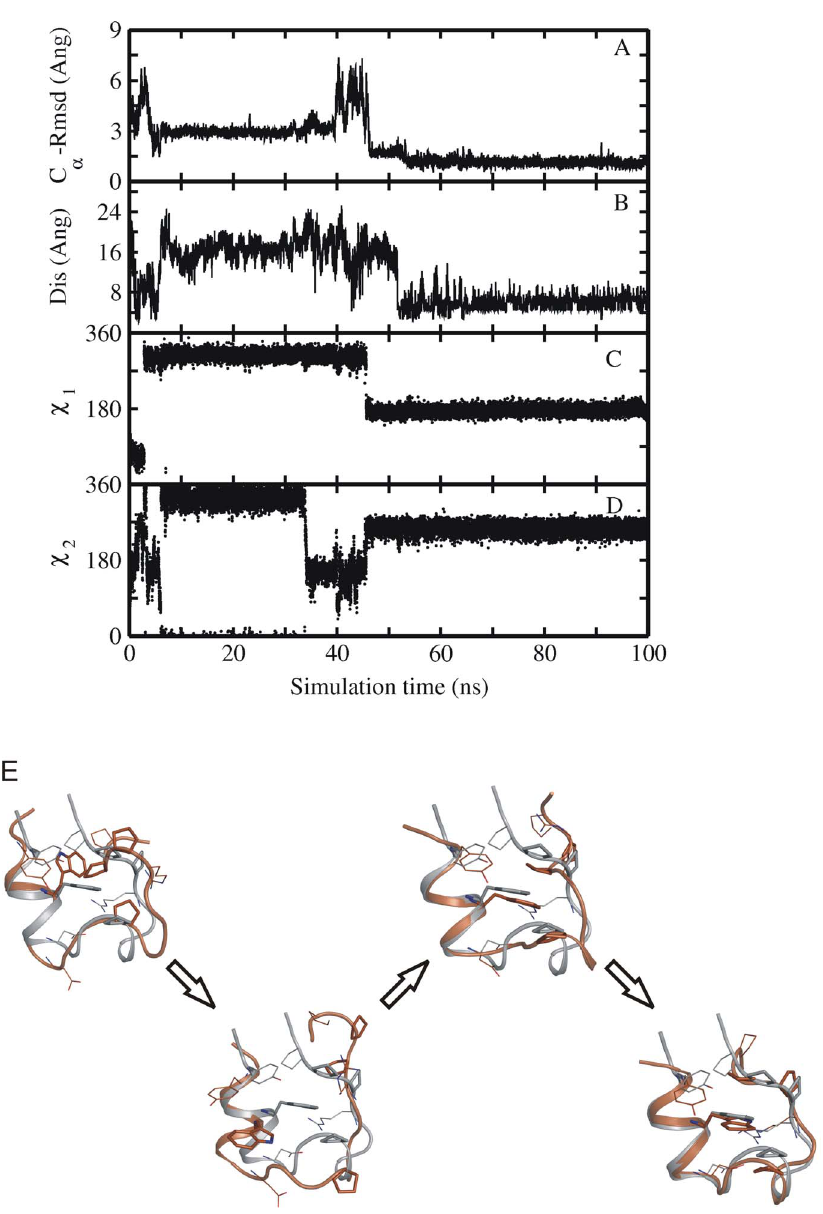
Figure 6. Time-dependence of backbone Rmsd and Trp6 side chain dihedral angles. (A) RMSD C a from native structure and (B) Asp9-Arg16 salt bridge distance as well as (C, D) side chain dihedral angels ( x 1 and x 2) of Trp-6 residue of sampled Trp-cage conformations along one folding trajectory starting from a set2 intermediate structure vs. simulation time (force field ff03). The dihedral angles of the native Trp6 side chain correspond to x 1 in trans ( , 180 u ) and x 2 in –gauche ( , 270 u ) (E) MD simulation snapshots showing the various steps in the folding process of the protein, as in the order of occurrence. Simulation snapshots (gold ribbons) are superimposed onto the native structure (grey ribbons), and key residues (Tyr3, Trp6, Ala9, Pro12, Arg16 and Pro17-19) are shown as sticks (same color coding as for